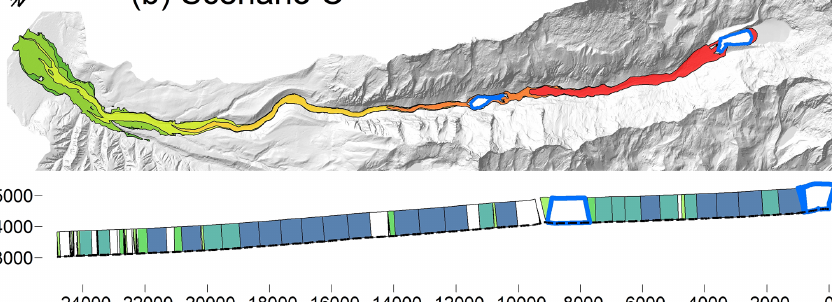
Figure 12. Travel times and frontal velocities for scenarios (a) B and (b) C. Note that the legend of (a) also applies to (b) . Void fields in the profile graph refer to areas without clearly defined flow